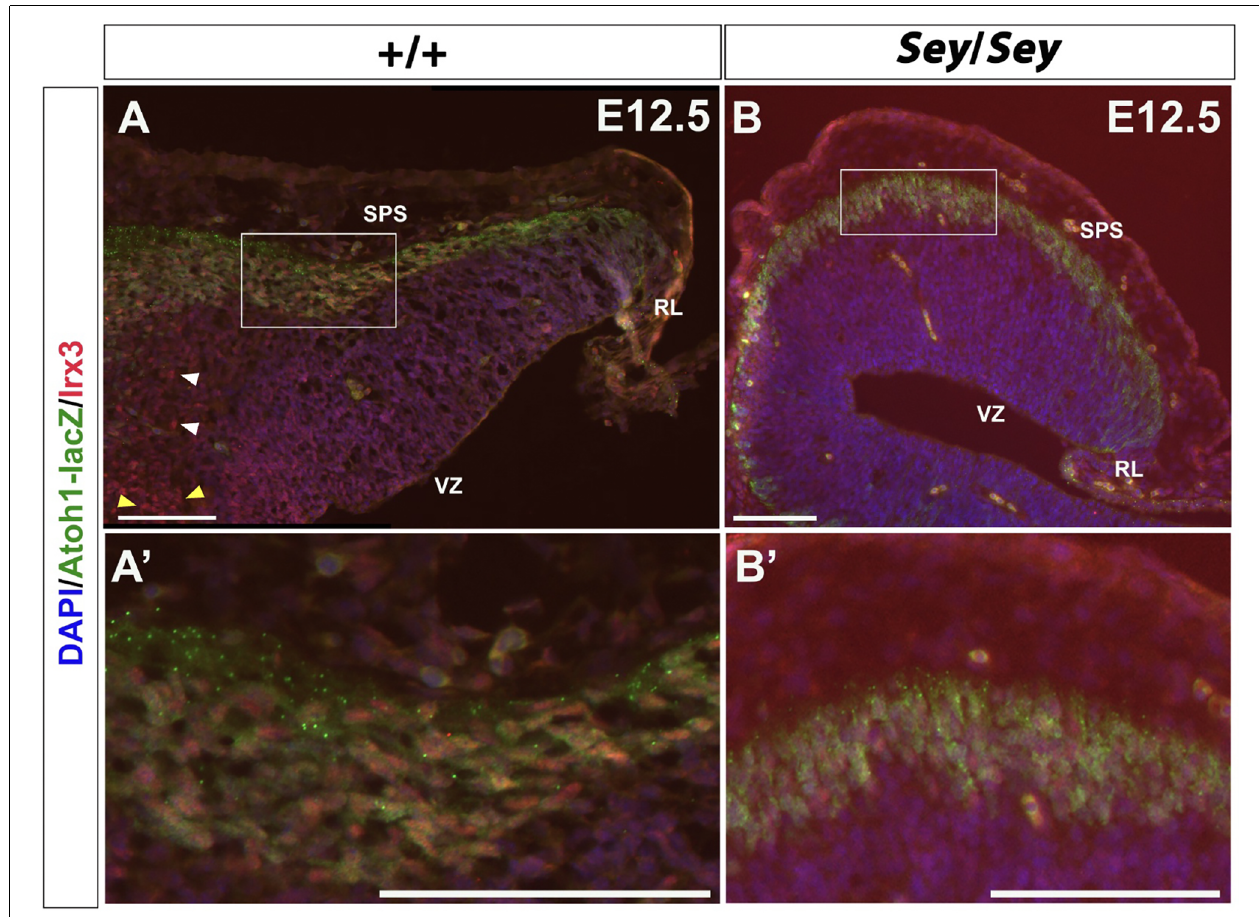
FIGURE 8 | Irx3-expressing cells along the subpial stream (SPS) are derived from Atoh1 + progenitors and persist in the absence of Pax6. (A) In the E12.5 cerebellum, Irx3 + cells are present in not only the ventricular zone (VZ) (yellow arrowheads) and cerebellar parenchyma (white arrowheads), but also in the SPS. (A’) Higher magnification image of the boxed region in (A) . (B) Similar to Pou3f1 and Brn2, Irx3 expression persists in the Sey mutant cerebellum. (B’) Higher magnification image of the boxed region in (B) . The cerebellar sections shown are sagittal sections. RL, rhombic lip; SPS, subpial stream; VZ, ventricular zone. Scale bars, 100 µ m.